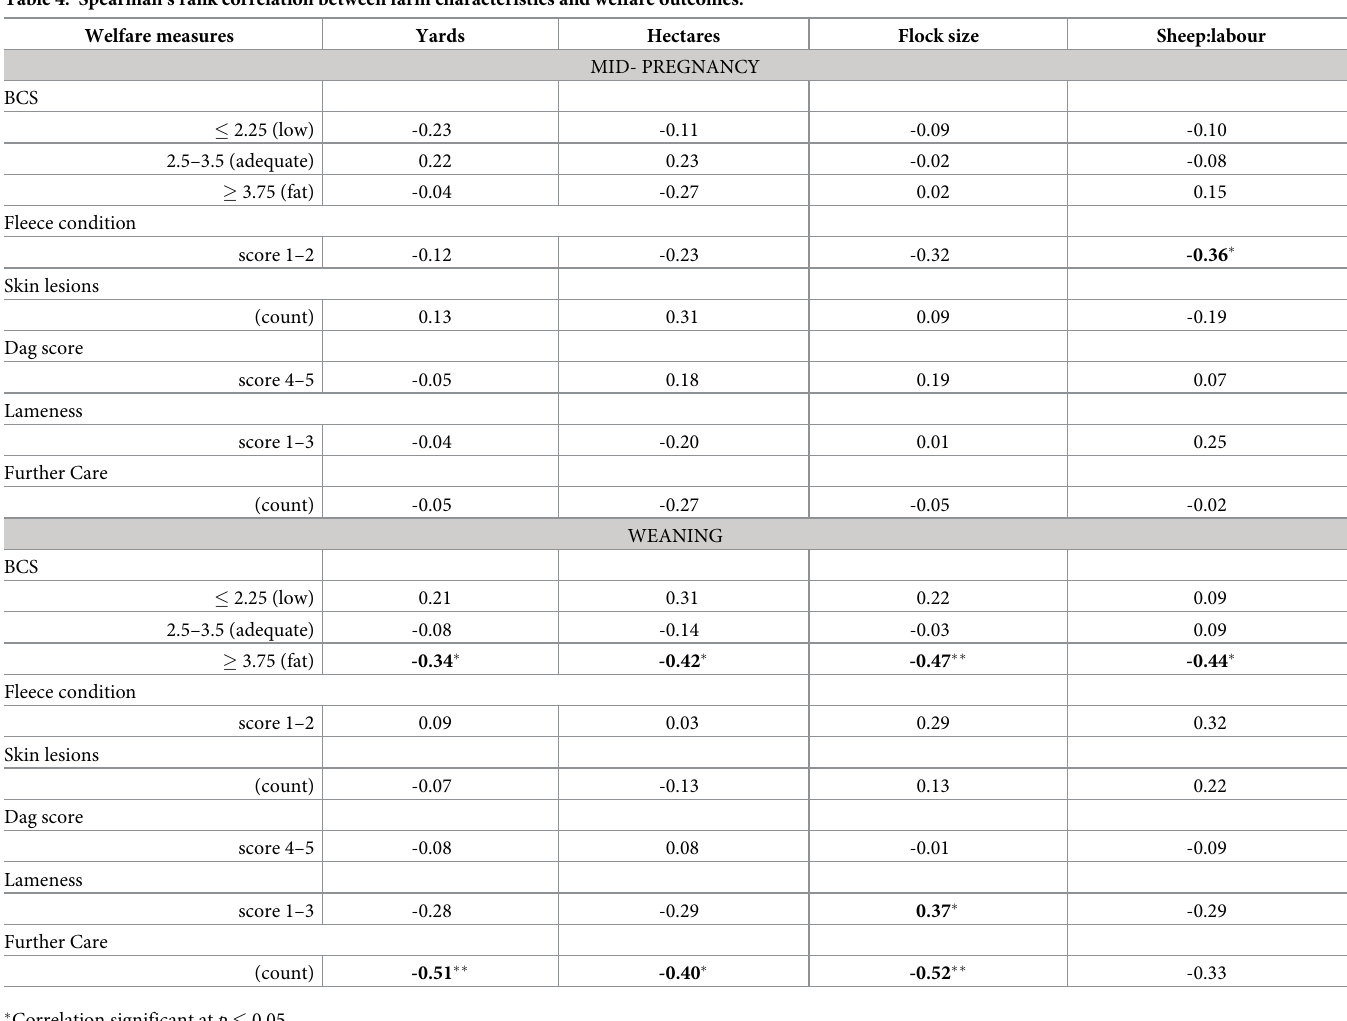
Table 4. Spearman’s rank correlation between farm characteristics and welfare